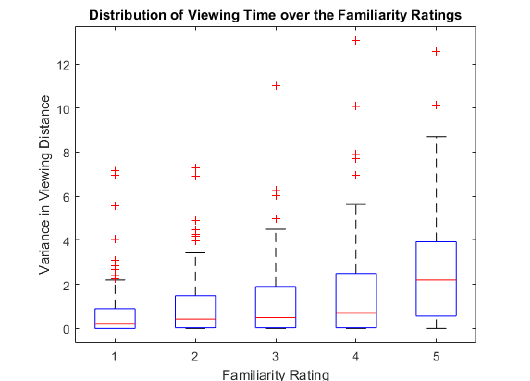
Figure 11: Houses that were looked at for a longer time had an overall higher familiarity (and navigation, not depicted) rating.